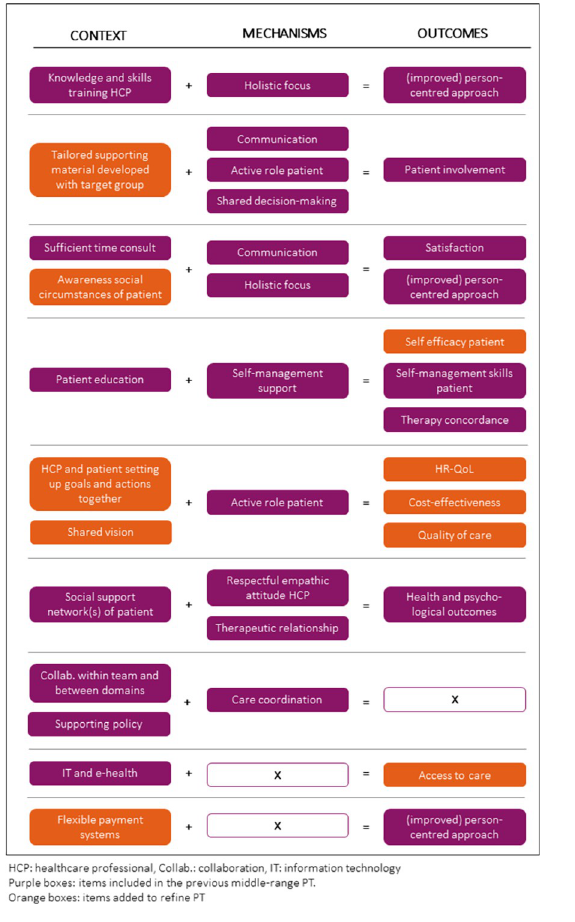
Fig 4. Refined PT by